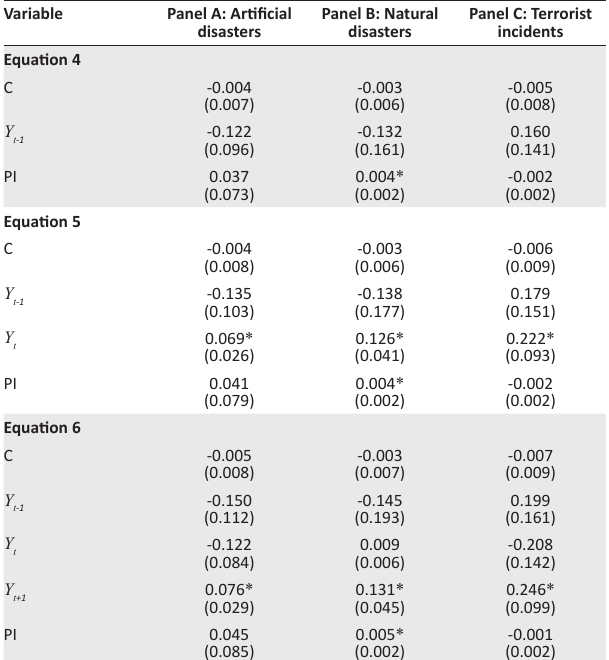
TABLE 3: Regression estimates comparing the effect of three types of events – artificial disasters (Eqn 4), natural disasters (Eqn 5) and terrorist incidents (Eqn